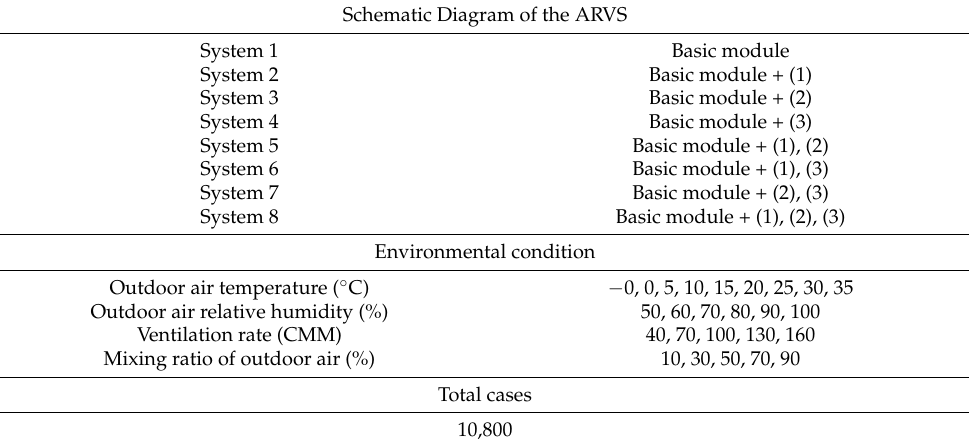
Table 4. Total cases to determine optimal air recirculated ventilation system according to the combi- nation of (1), (2), and (3)